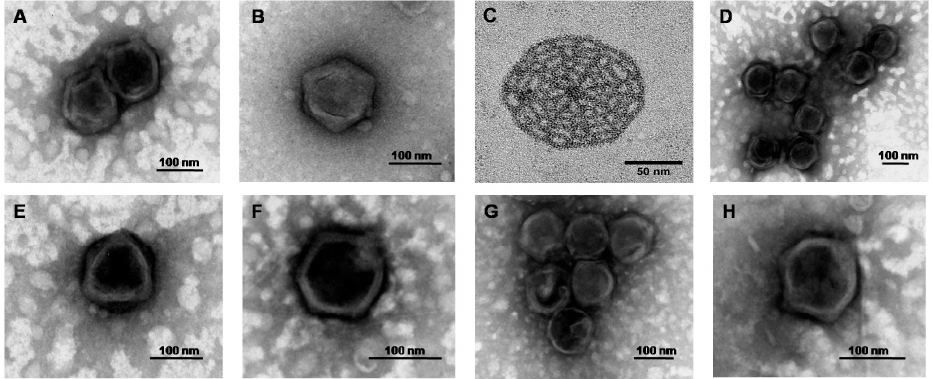
Figure 1. Negatively stained transmission electron microscopy micrographs of ( A , B ) Micromonas pusilla viruses (MpVs); ( C ) ‘Spiderweb’-like plate from exterior of Bathycoccus prasinos cell; ( D – H ) O. tauri viruses (OtVs).